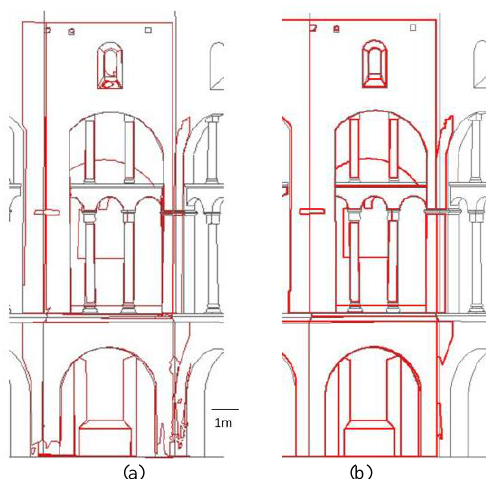
Figure 16. Superimposition of the final extracted sectional view (red) and the reference view (grey); a) result obtained without corrections; b) result obtained after manual